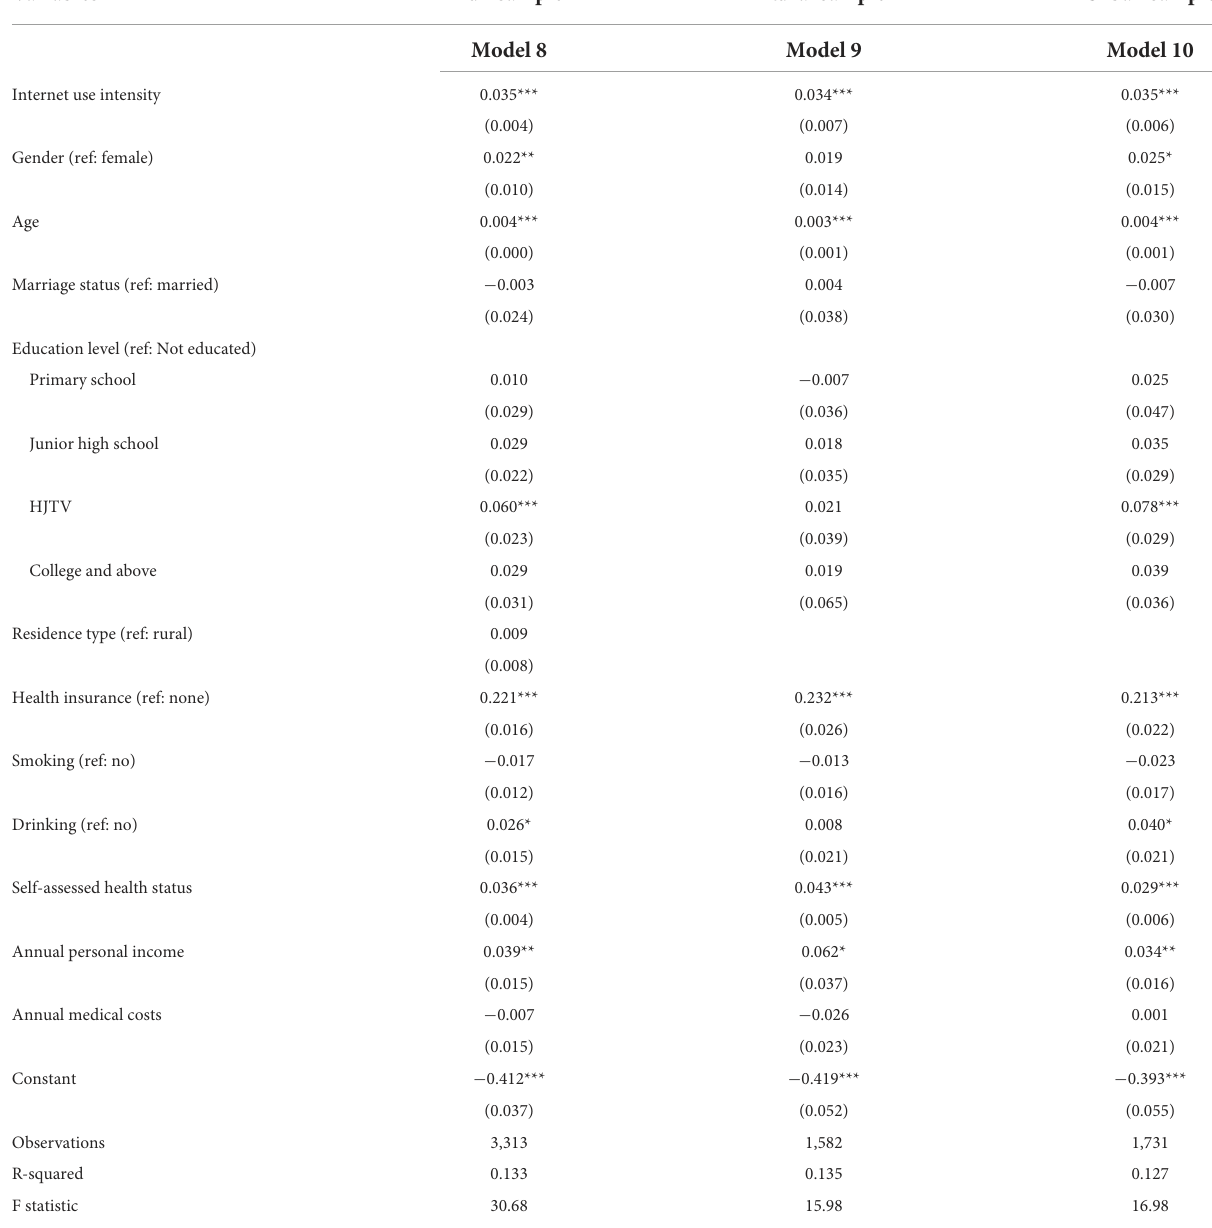
TABLE 7 Results of the relationship between internet use intensity and quality of life ( N =